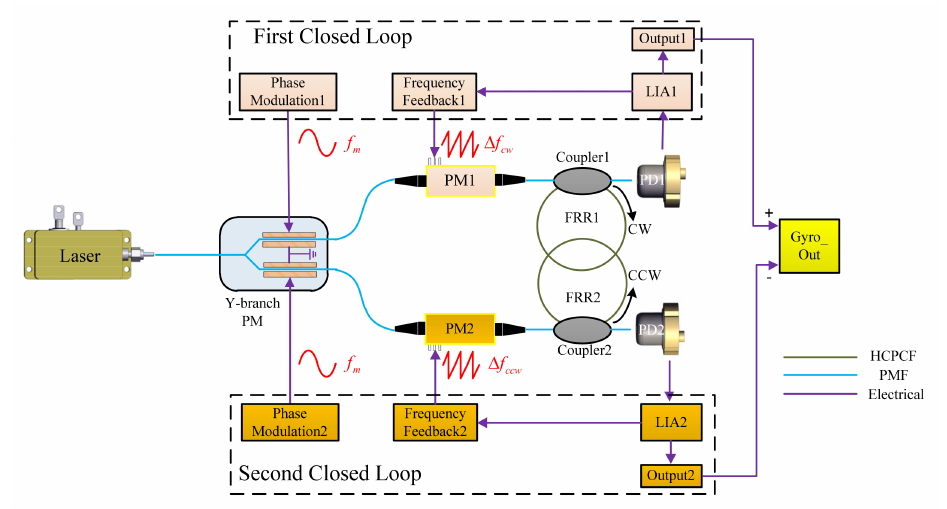
Figure 1. Schematic diagram of the PDHC-RFOG